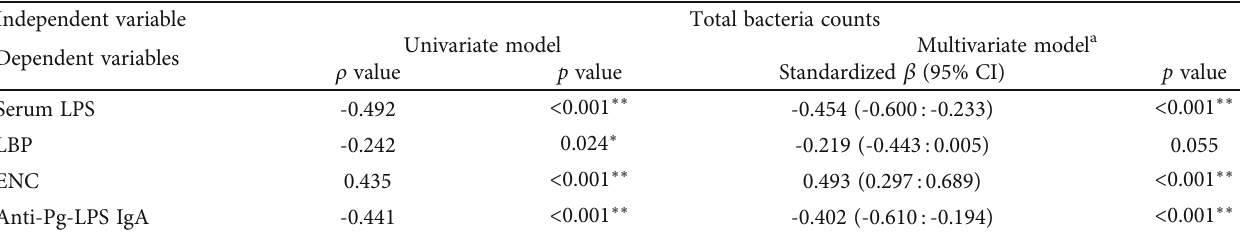
Table 5: Univariate and multivariate regression analyses between total bacteria counts and bacterial biomarkers. Independent variable